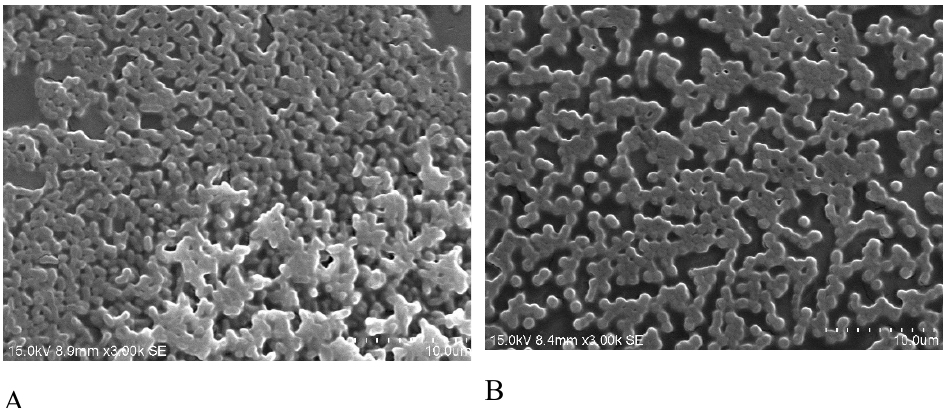
Figure 3. Scanning electron micrograph images of A. baumannii biofilm on the surface of minimum biofilm eliminating concentration (MBEC) device. ( A ), strong biofilm formation; ( B ), moderate biofilm formation. Magnification 3000×; Bars = 10 µm.